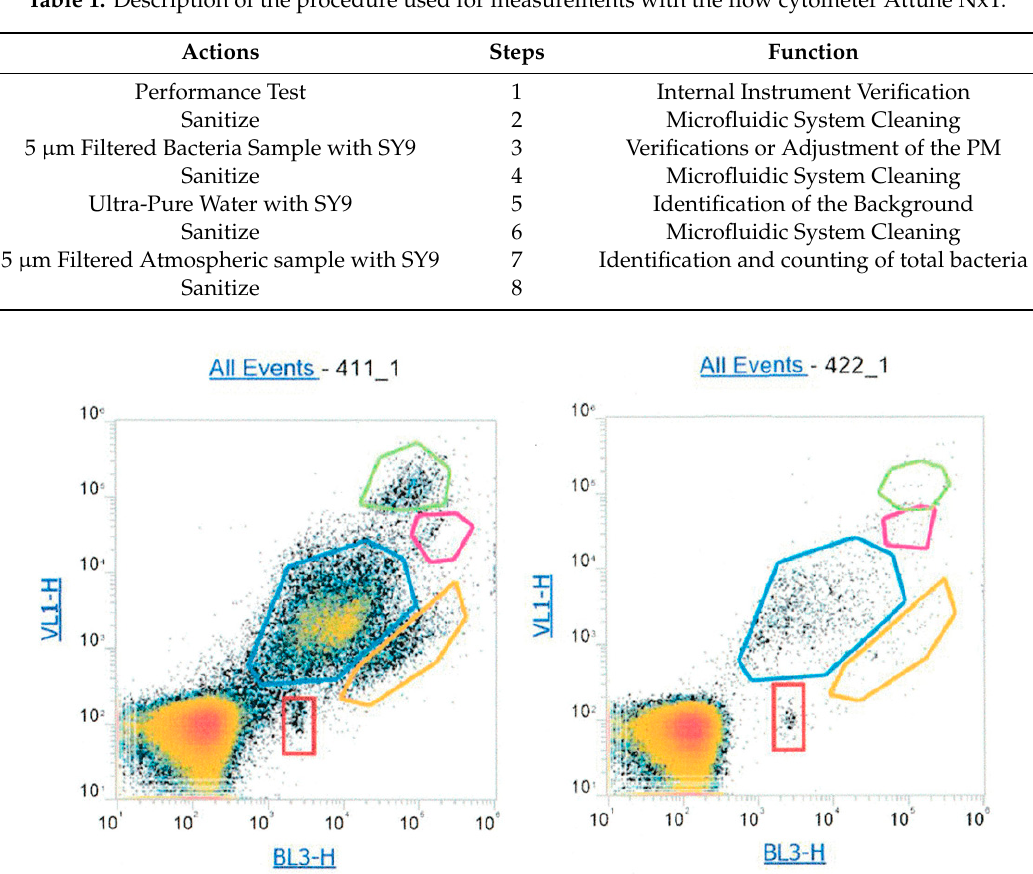
Figure 3. Microbial population distribution across unfiltered sample N411 (24 February 2019) and N422 (7 March 2019) were where VL1-H (440 / 50) is the fluorescence emission from violet (405 nm) laser, and BL3-H (695 / 40) is the fluorescence emission from the blue laser (488 nm). The combination of these 2 fluorescence emission detectors gave the broadest population distribution.